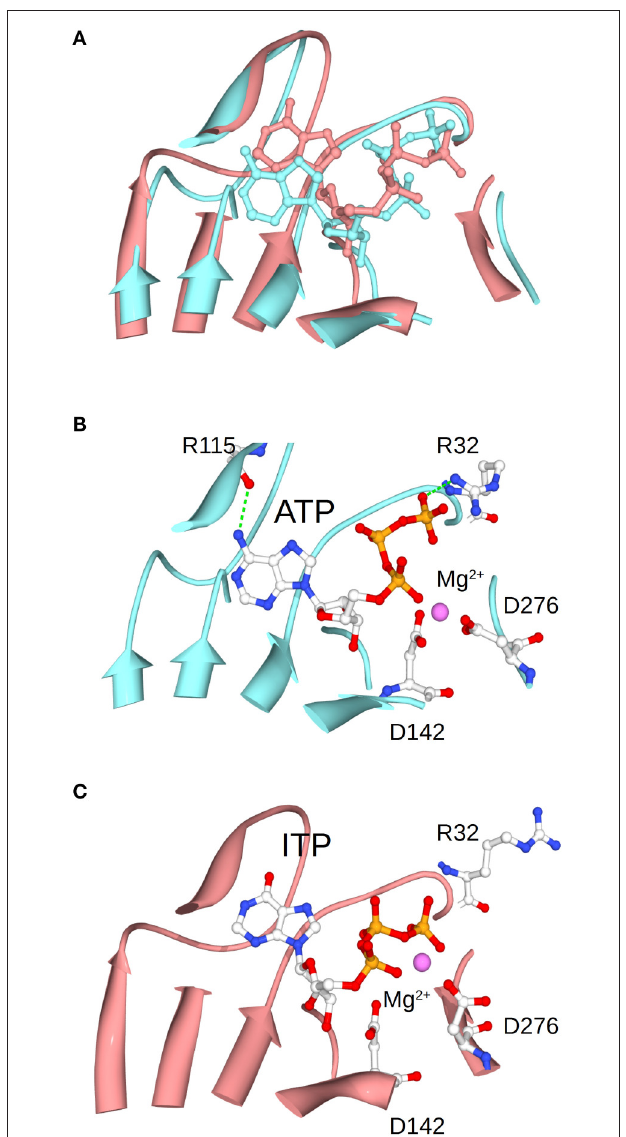
FIGURE 7 | Positioning of ATP and ITP in the MD simulations. (A) Shows the overlap of the conformations of ATP and ITP in subunit A at the midpoint of the MD simulation. (B,C) Separately show the ATP and ITP, respectively. Structures were aligned based on the residues shown in the picture as ribbons, which are the one surrounding the substrate.